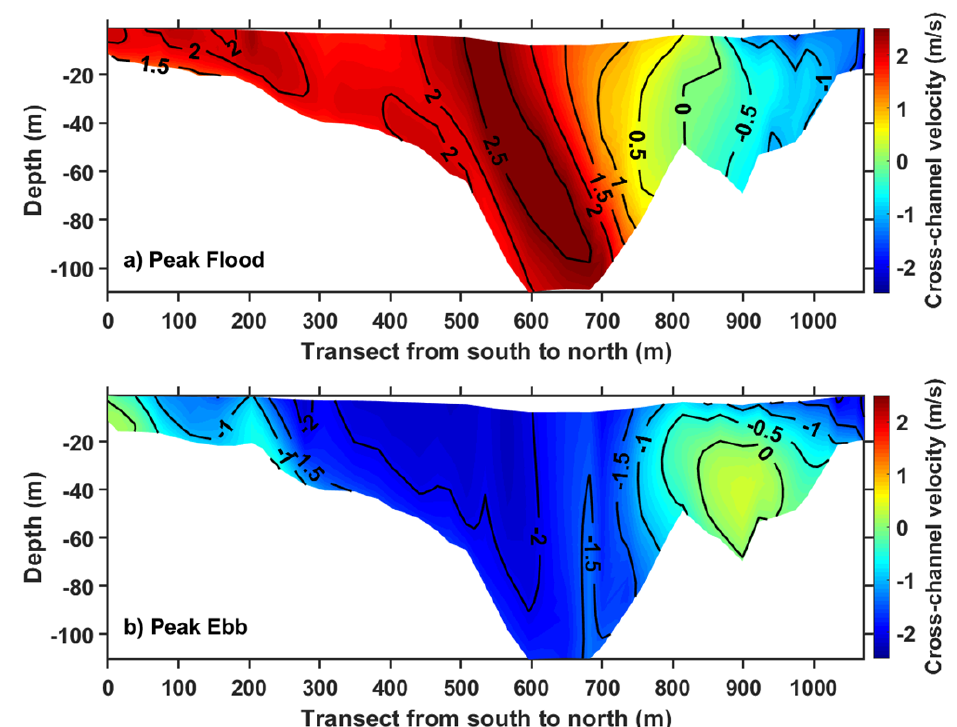
Figure 9. Normal velocity magnitudes at ( a ) peak flood and ( b ) peak ebb tides along cross section XS1 in the Western Passage. Positive velocity is away from the reader. The cross-section location is shown in Figure 1.